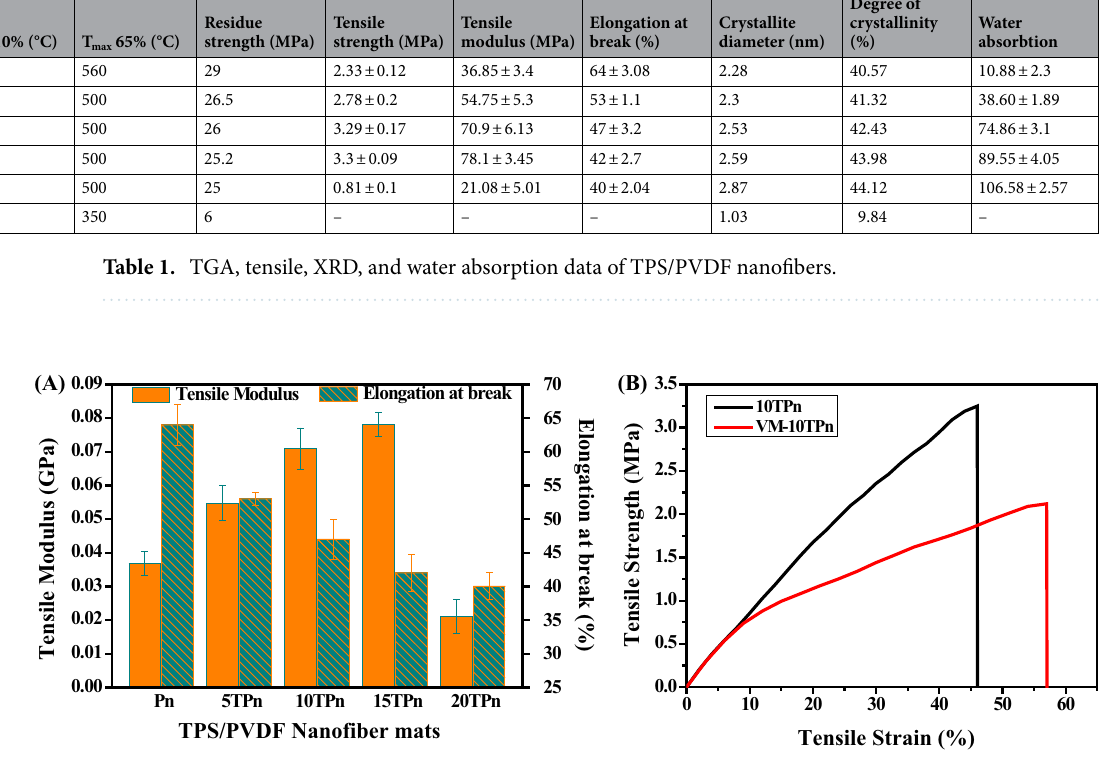
Figure 5. ( A ) Tensile modulus and elongation at break ( B ) stress–strain curves of TPS/PVDF